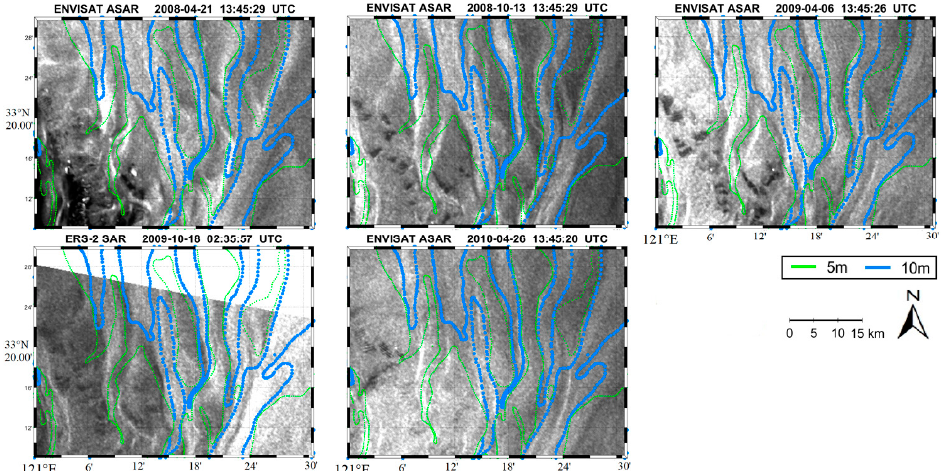
Figure 4. SAR sub-images over Subei Bank with bathymetric features shown as wide bright stripes. Green and blue lines are water depth contours of 5 and 10 m, respectively.